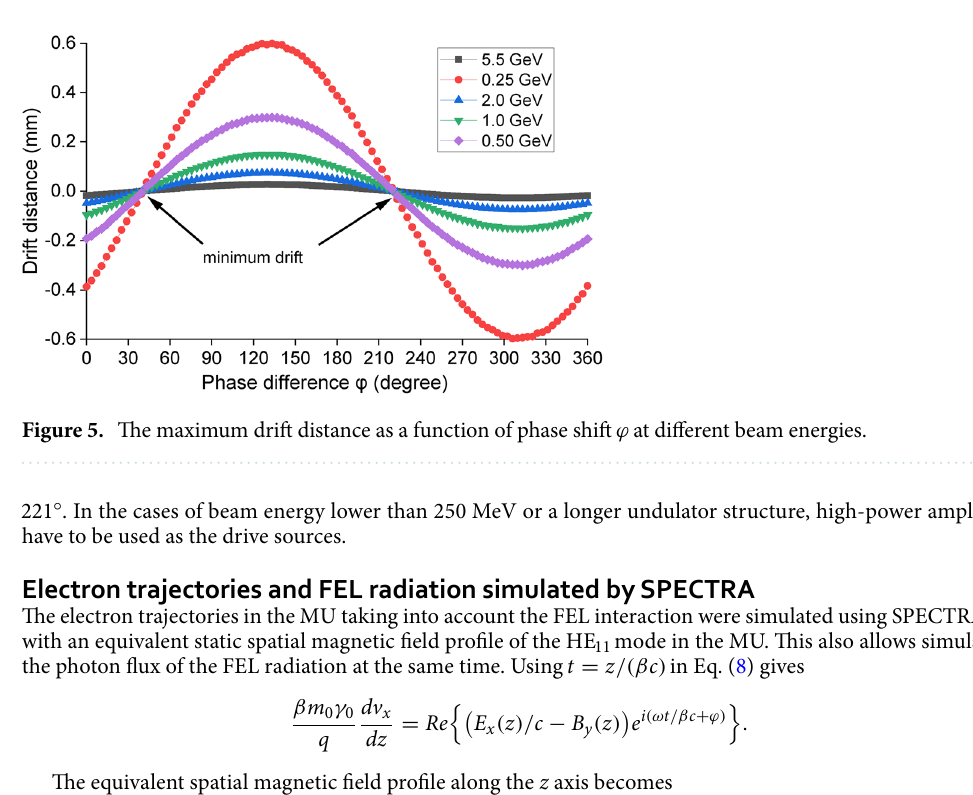
Figure 4. Trajectories of the electrons with 5.5 GeV energy at different phase shifts ϕ inside the MU.